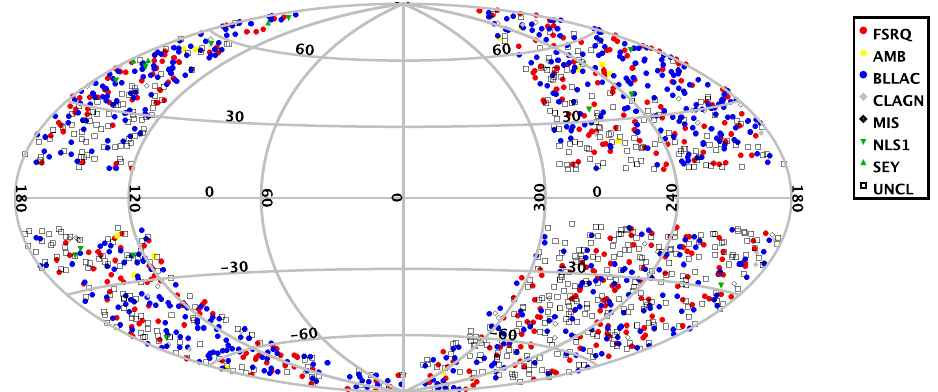
Figure 1. Distribution in the sky (Galactic coordinates) of the checked